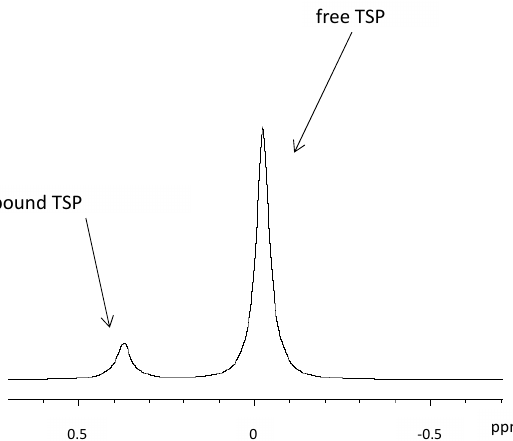
Figure 5. Influence of TSP interaction with tissue on the quantification with 1 H HR-MAS NMR spectroscopy.